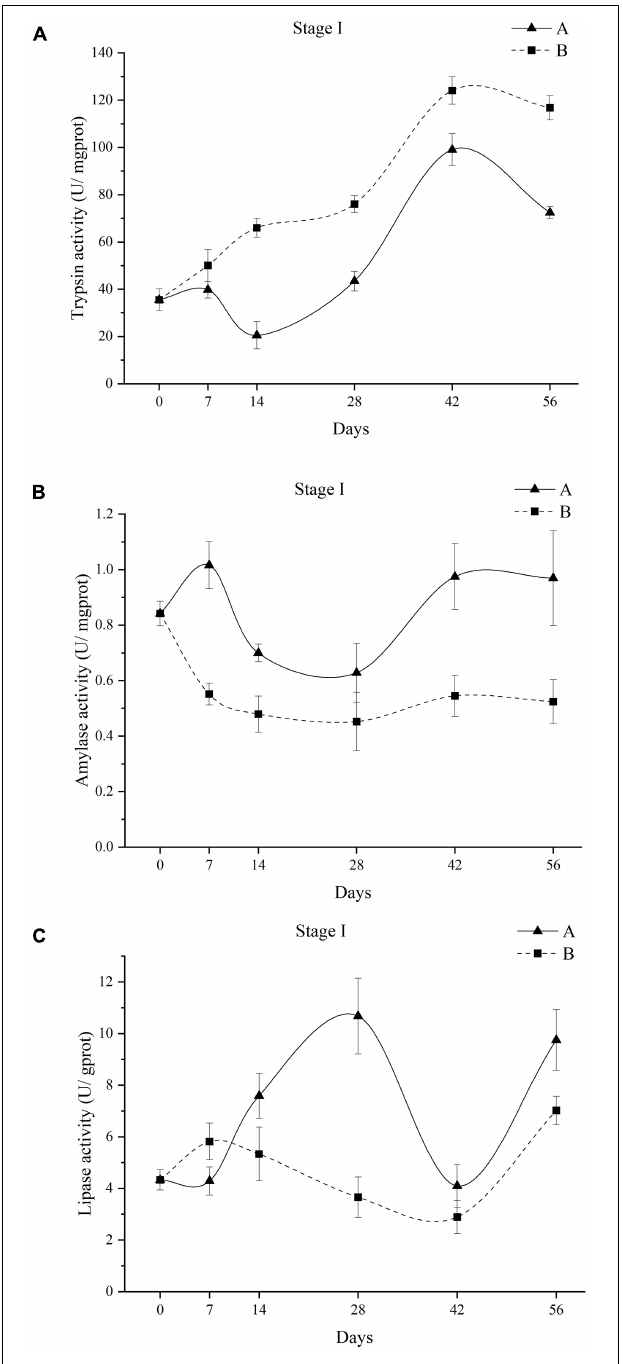
FIGURE 2 | Changes in trypsin activities of A. japonicus feeding different diets in stage I (A) ; Changes in amylase activities of A. japonicus feeding different diets in stage I (B) . Changes in lipase activities of A. japonicus feeding different diets in stage I (C) . Data are presented as mean ± SD ( n = 3).